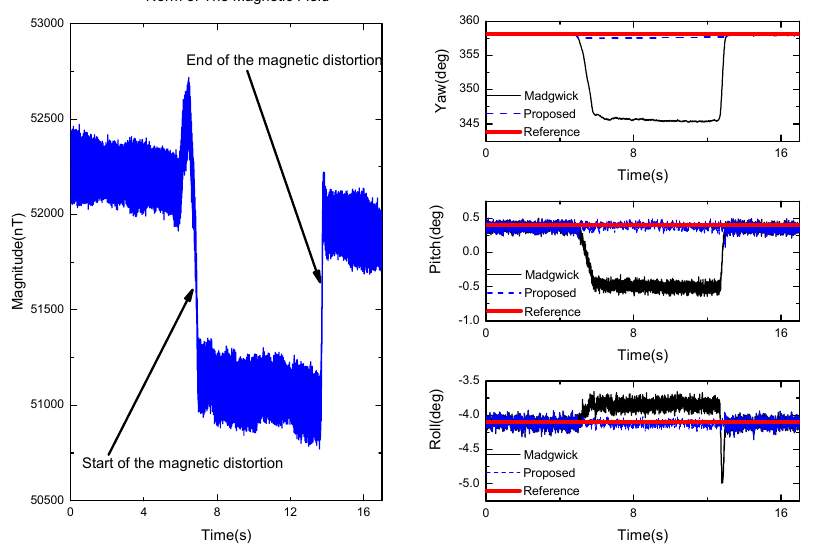
Figure 15. The norm of the magnetic field ( left ) and the orientation produced by the proposed (blue, µ a = 0.9), Madgwick’s complementary filer (black, β = 0.8 ) ( right algorithm (blue, a 0.9   ), Madgwick’s complementary filer (black, 0.8  ) ( right ).